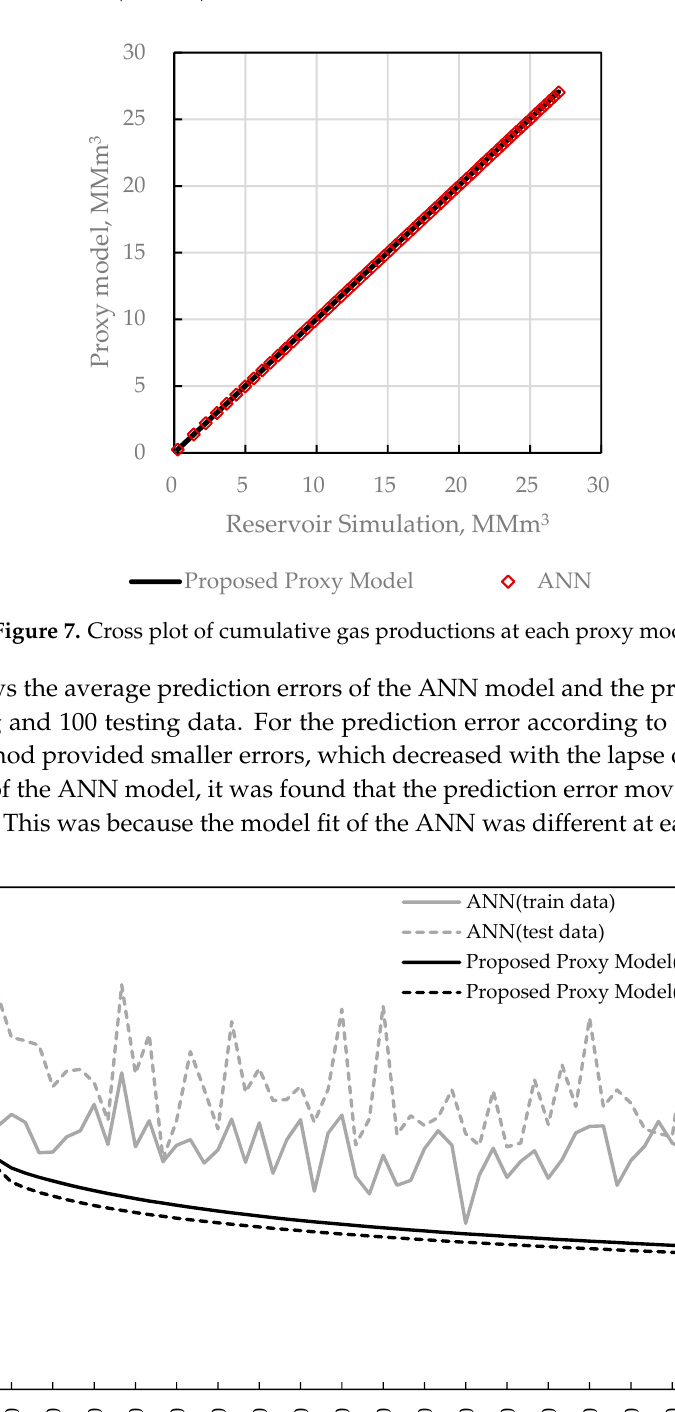
Figure 8. Prediction accuracy of artificial neural network (ANN) model and the proxy model.